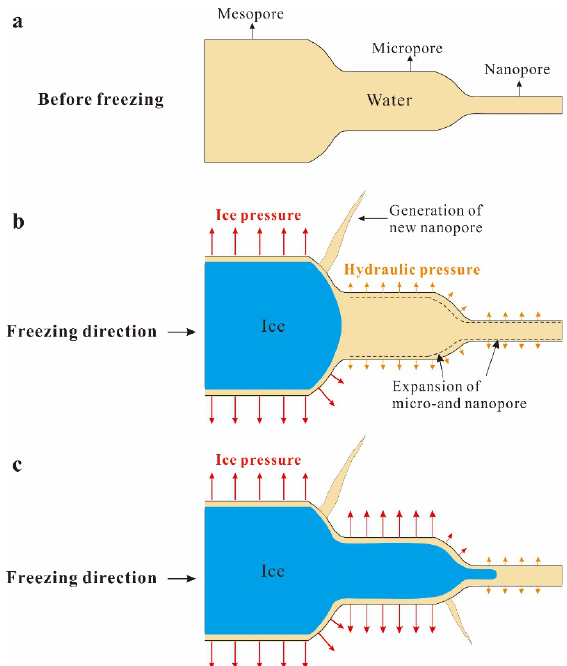
Figure 10. Connected pores in tight sandstone and mechanisms of frost damage (not to scale), ( a ) initial pores filled with water before freezing, ( b ) freezing of pore water initiates from mesopores and ( c ) ice crystal grows into micro- and